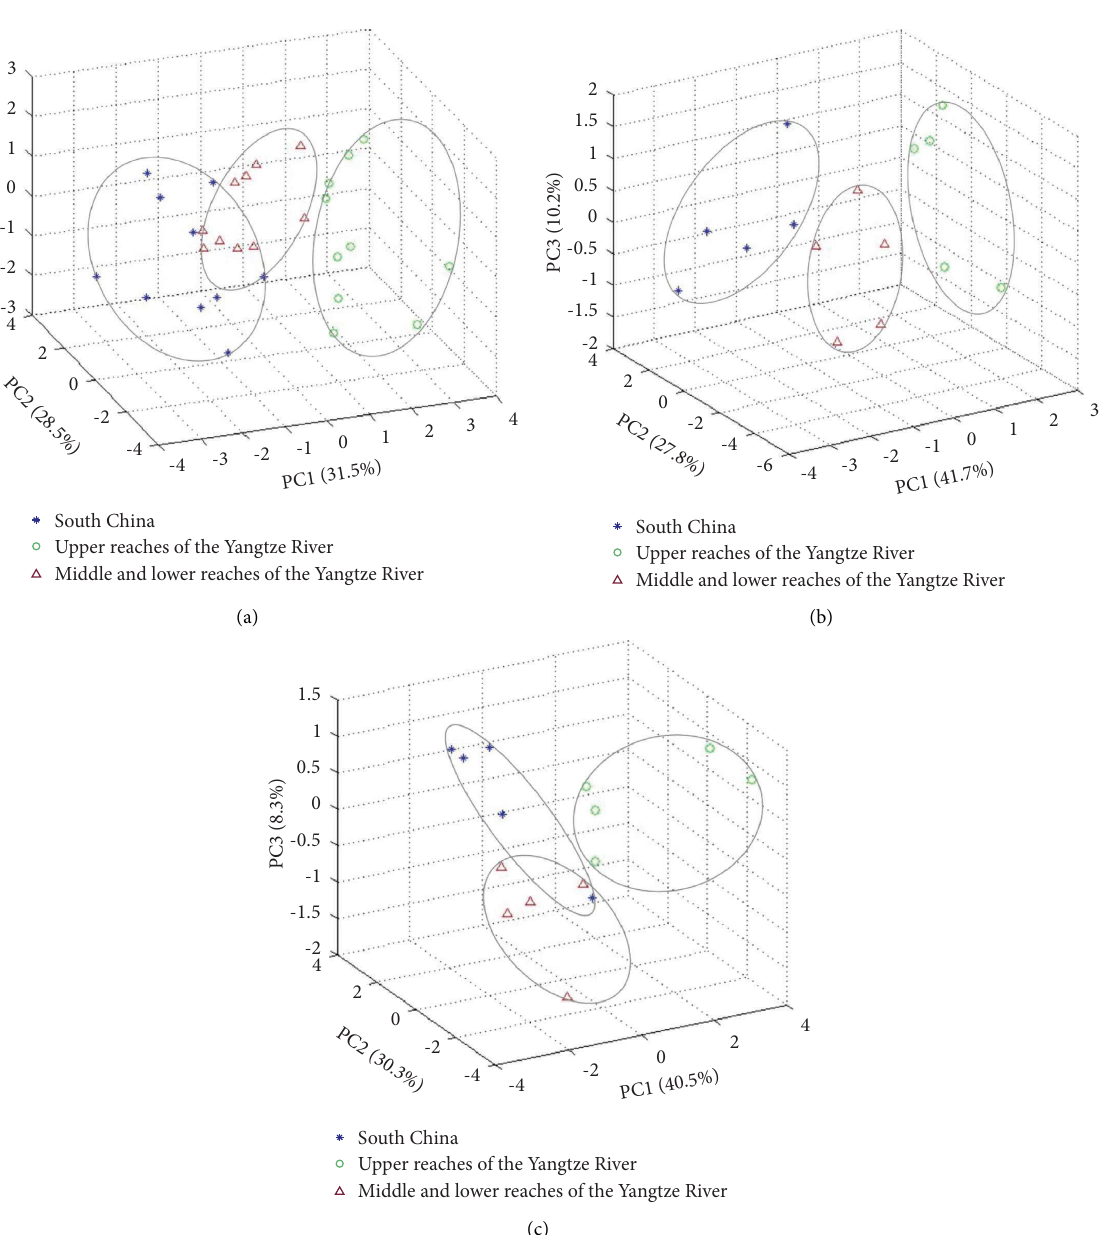
Figure 2: PCA chart of rice from the three regions, including South China, the upper reaches of the Yangtze River, and the middle and lower reaches of the Yangtze River. (a) Ten years; (b) the frst fve years; (c) the latter fve